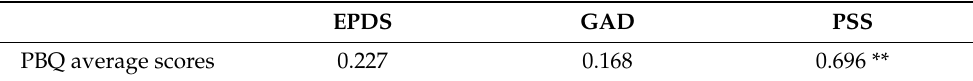
Table 4. Pearson correlation results of Maternal-Infant bonding with depressive symptoms, anxiety, and stress.